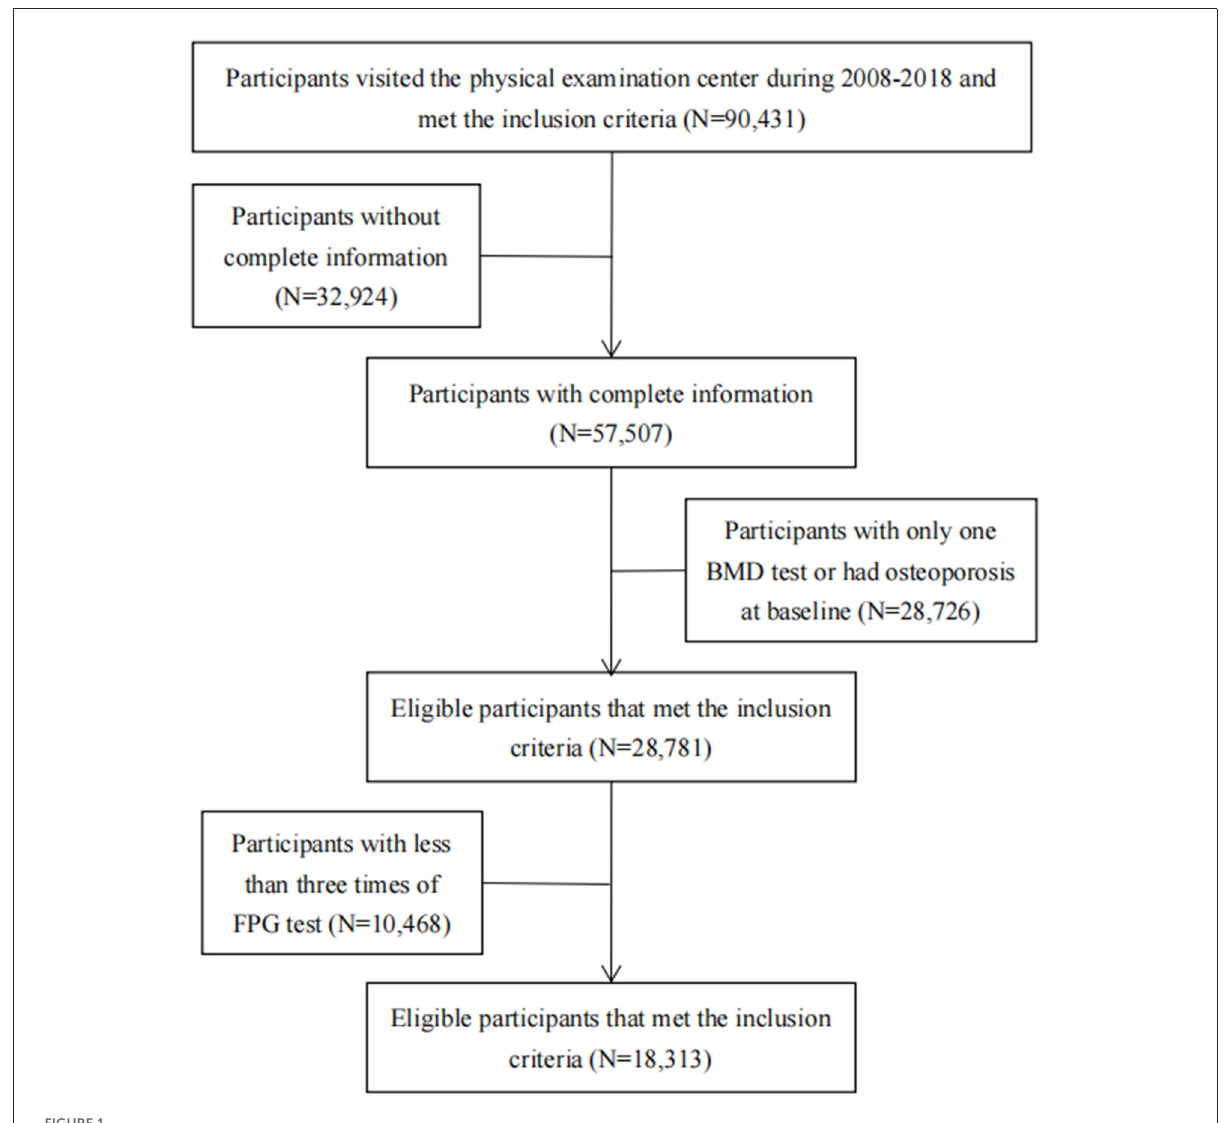
FIGURE1 Flowchart of the